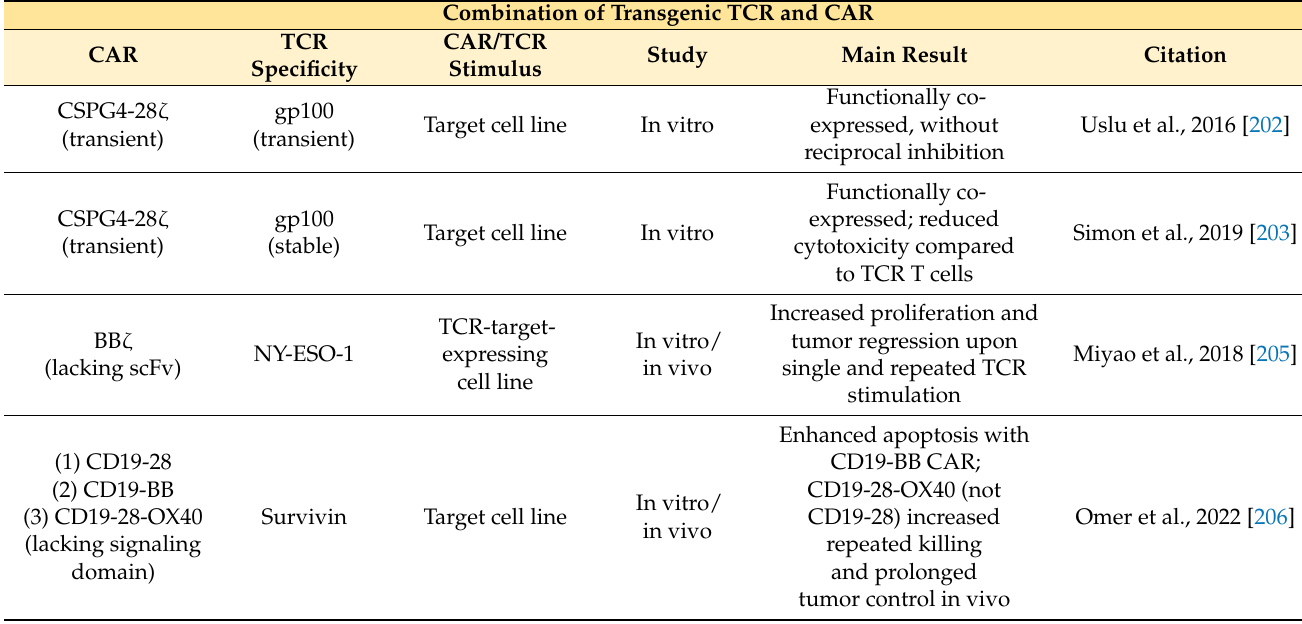
Table 3. Overview of studies combining transgenic TCR and